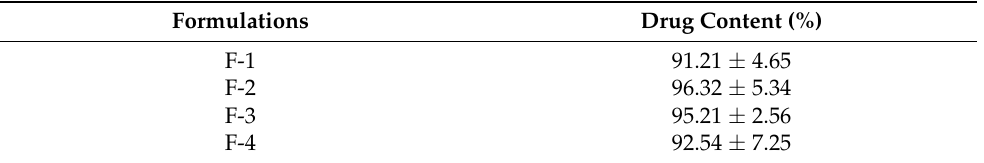
Table 3. Drug content of optimized SEDDS formulations (mean ± SD, n = 3) .